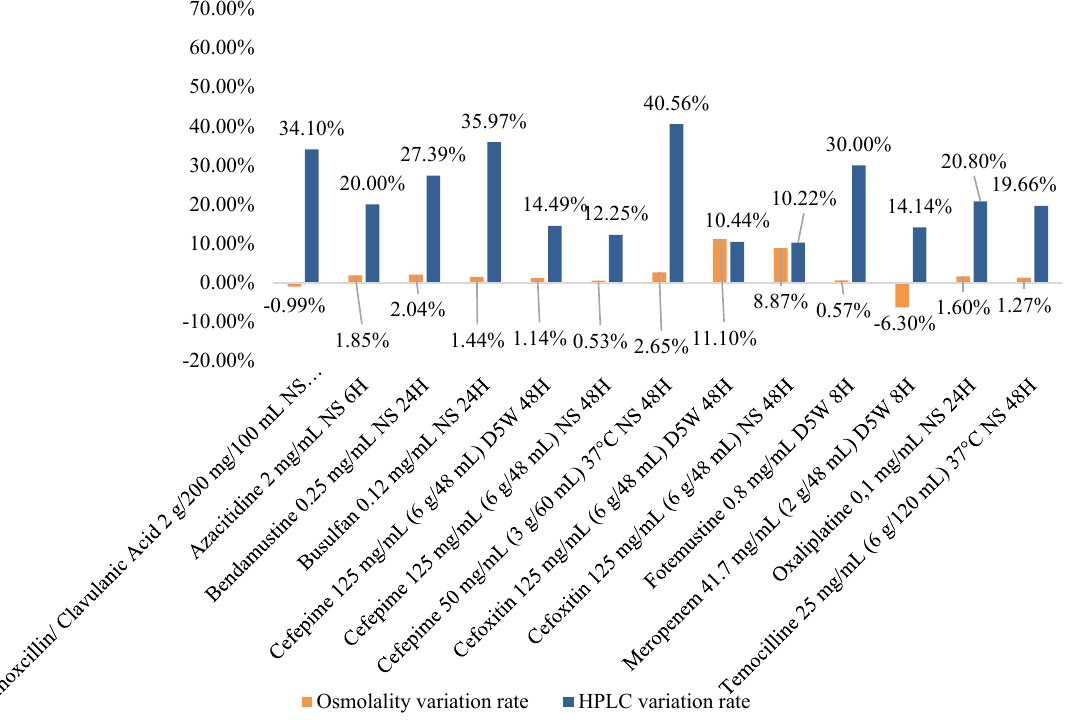
Figure 1: Comparison of the variation rate in osmolality with the rate of degradation measured by